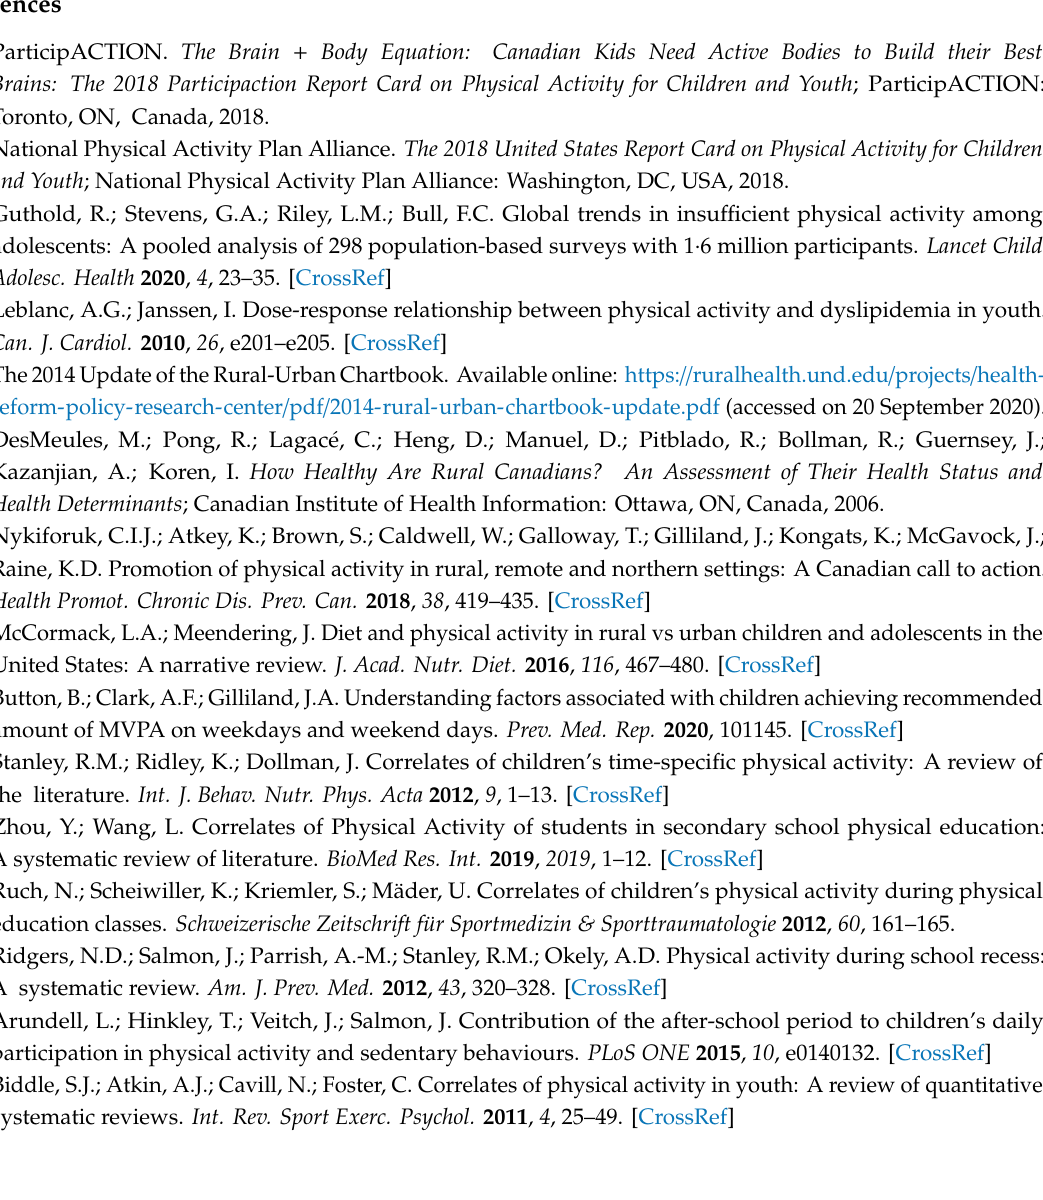
Figure S1: FLOW diagram of final sample